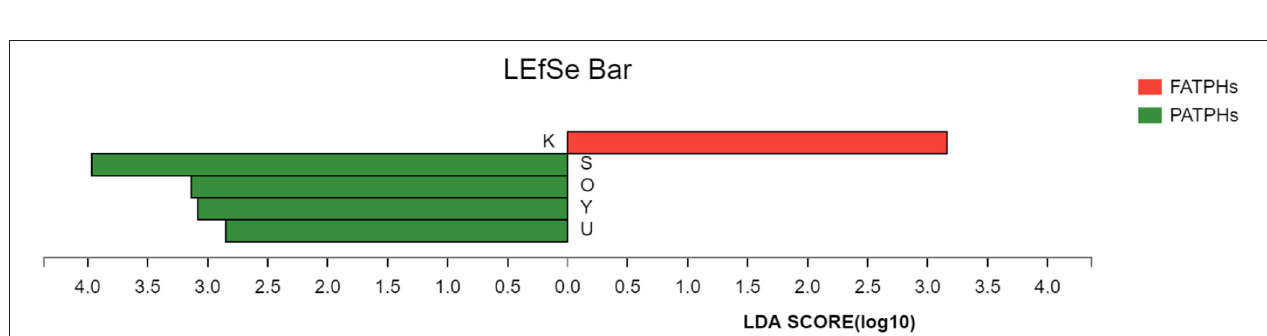
FIGURE 11 | Cladogram showing the COG functions with significant differences between FATPHs and PATPHs. Functions with significant difference that have an LDA score > the threshold value of 3 are shown. K represents function of Transcription; S represents function of Function unknown; O represents function of Post-translational modification, protein turnover, and chaperones; Y represents function of Nuclear structure; and U represents function of Intracellular trafficking, secretion, and vesicular transport. The red bar represents samples of FATPHs, while green bars represent samples of PATPHs.